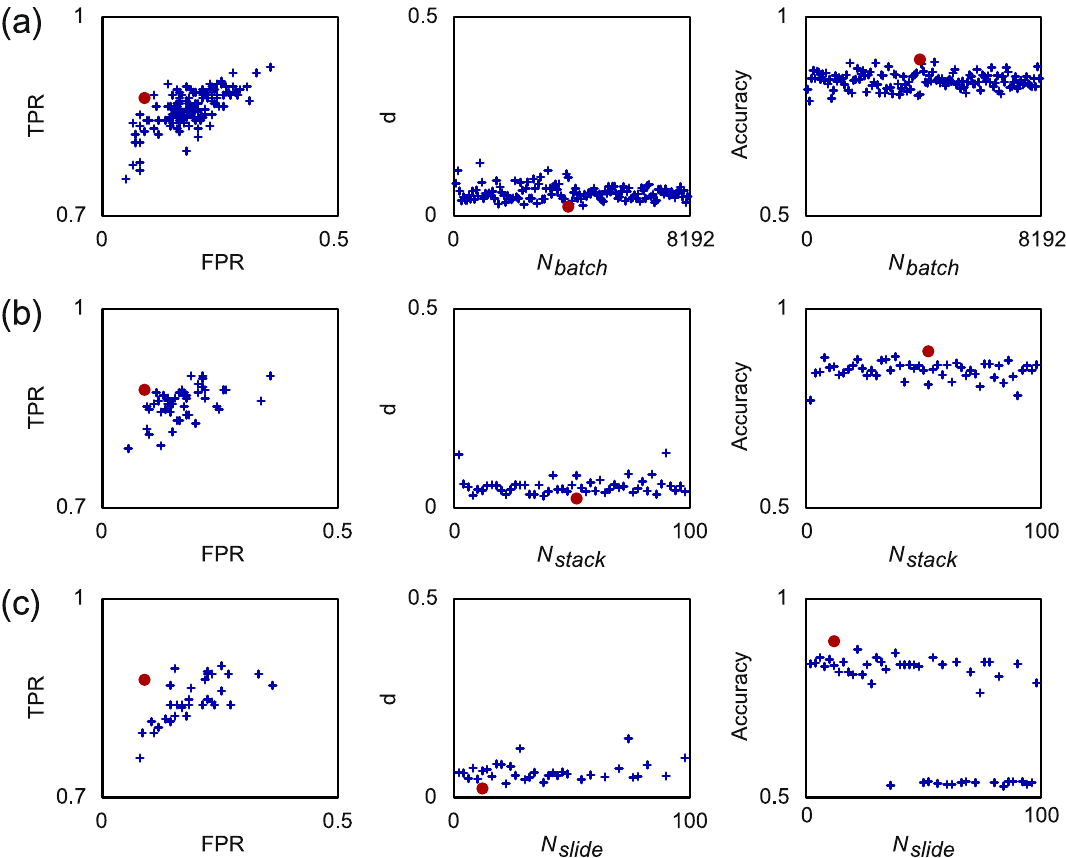
Figure 6. Results of hyperparameter tuning obtained with SMNN 5. ( a ) Batch size N batch , ( b ) number of frames per input vector N stack , and ( c ) offset between two consecutive input vectors N slide . Left: TPR vs. FPR scores for hyperparameter tuning (the value closest to the TPR = 1 and FPR = 0 corresponds to the best perfromance). 2 + ( FPR ) 2 Middle: distance d = (cid:31) ( 1 − TPR ) with respect to TPR = 1 and FPR = 0 (the lowest value corresponds to the best performance). Right: classification accuracy (the highest value corresponds to the best performance). Red dot denotes the parameter with the best